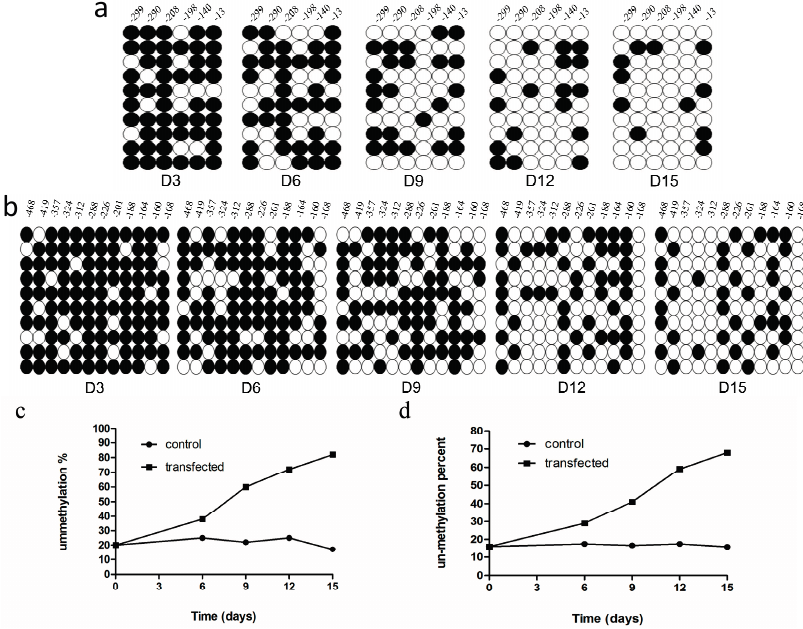
Figure 11. Epigenetic modification of the Nanog and Oct4 promoters during the mRNA iPS generation. Methylation status of CpGs islands (columns) were analyzed from 10 randomly sequenced clones (rows) in the promoter region of Nanog ( a ) and Oct4 ( b ) genes at different stages during reprogramming (D3, D6, D9, D12 and D15); Un-transfected MEF cells were used as control. Open circles indicate the un-methylated state and dark and filled circles indicate the methylated state; ( c , d ) The overall pattern and global analysis of the tested loci of Nanog and Oct4 promoters,